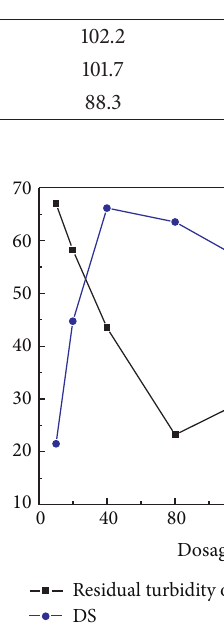
Figure 3: Effect of dosage on sludge dewatering performance.